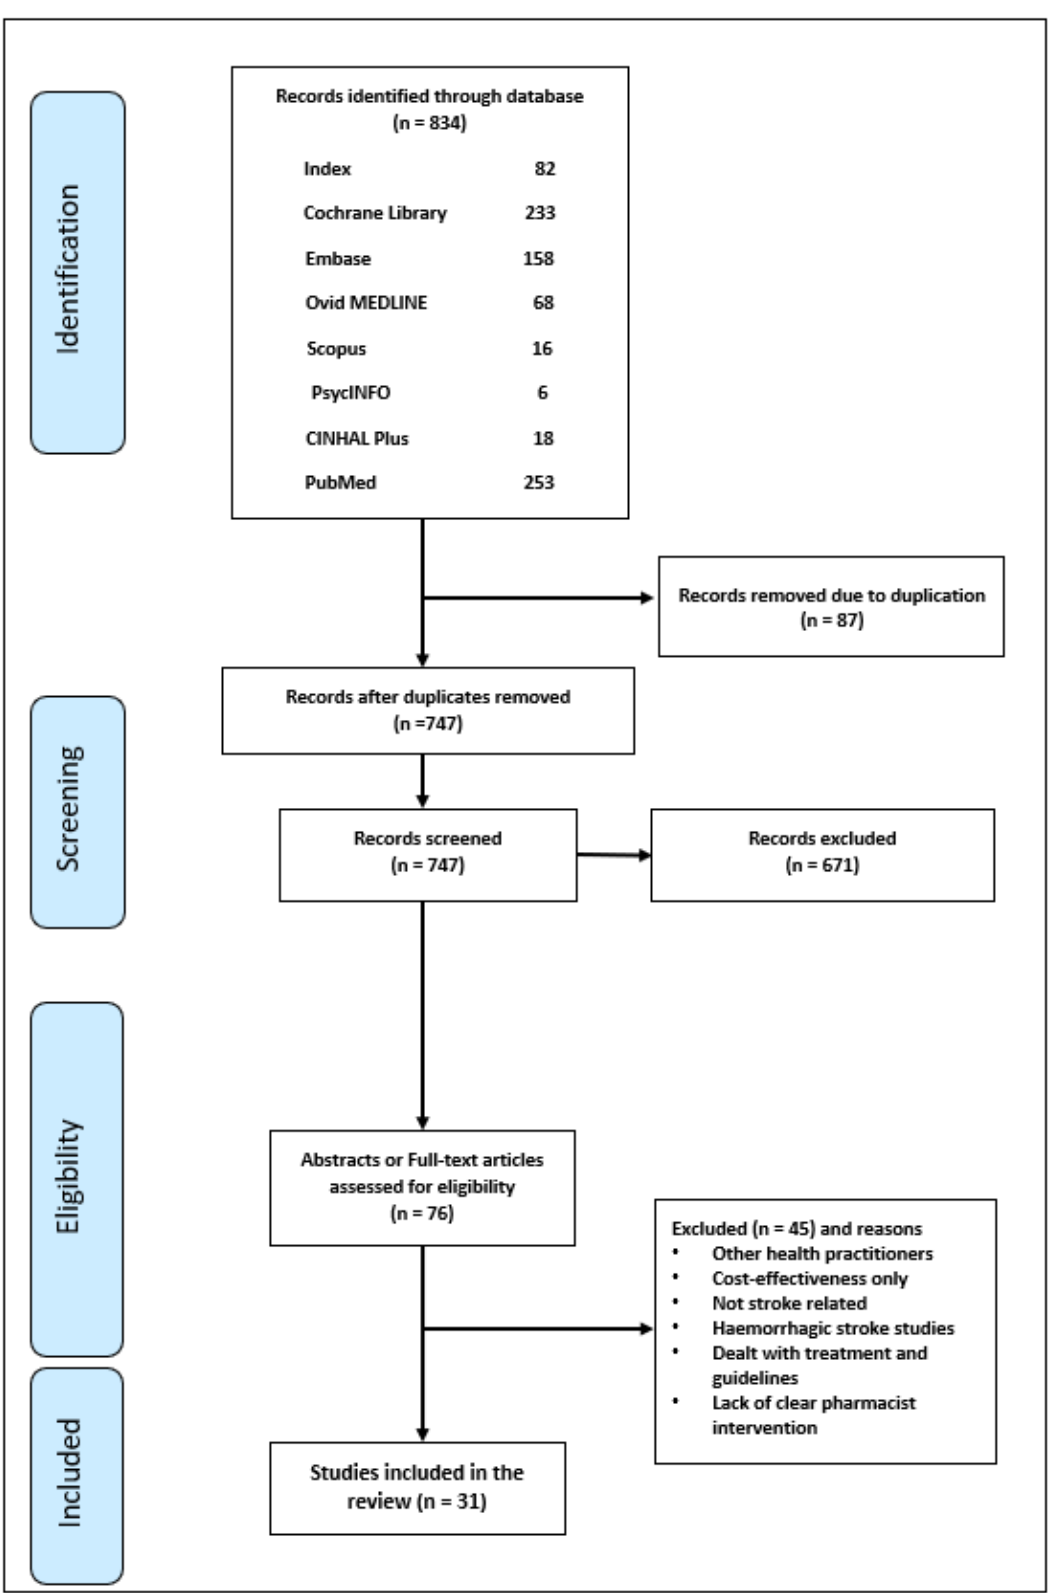
Figure 1. PRISMA flow chart of screening process and reasons for exclusion of studies.